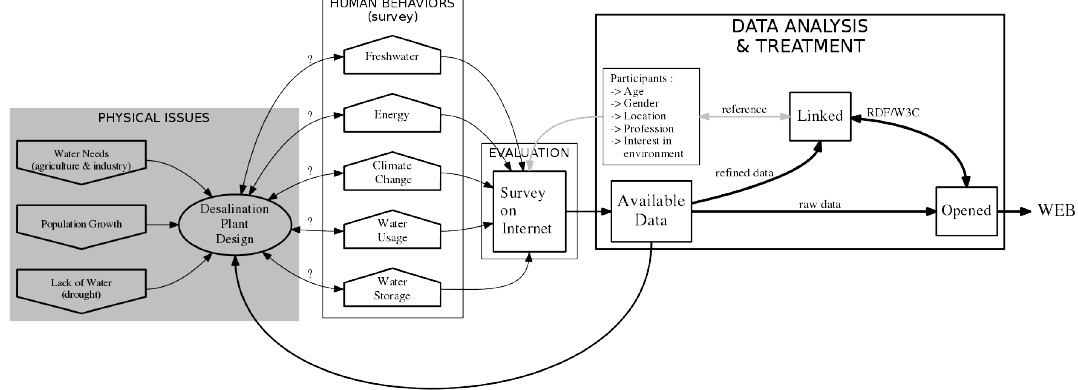
Figure 5. Chart flow of crowdsourcing geolocation data for desalination plant